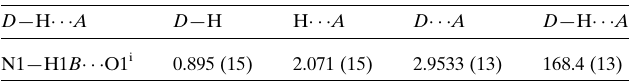
Table 1 Hydrogen-bond geometry (A˚ , (cid:4) ).